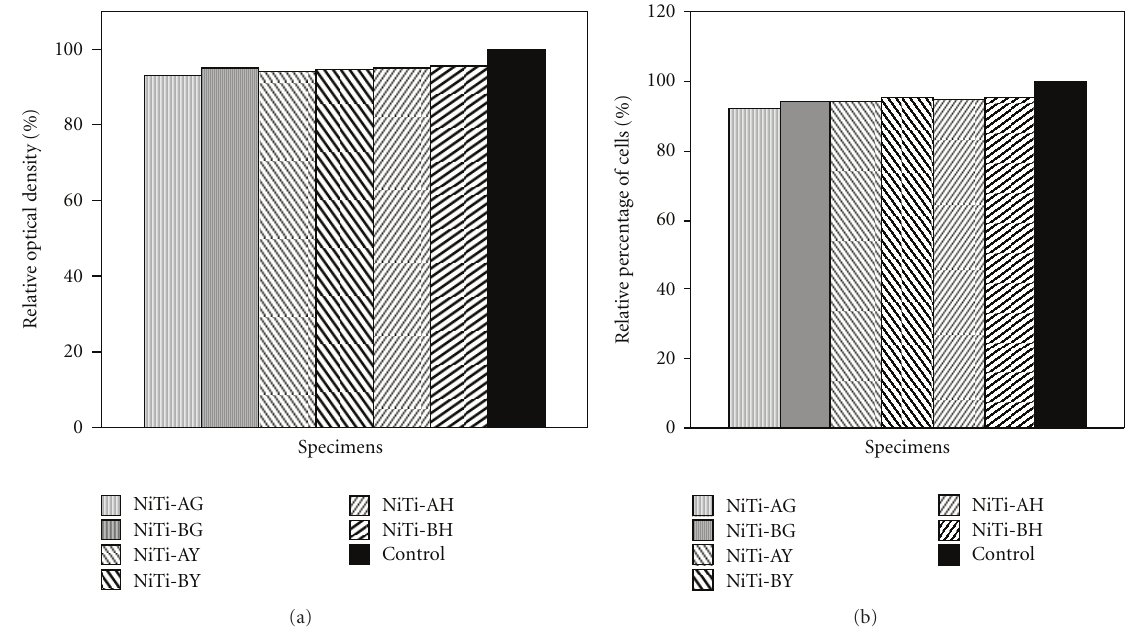
Figure 8: Cytotoxicity of the NiTi specimens di ff ering in surface properties: MTT test (a), cell counting in the Goryaev chamber (b); control cells cultivated with no specimen (cell control wells).